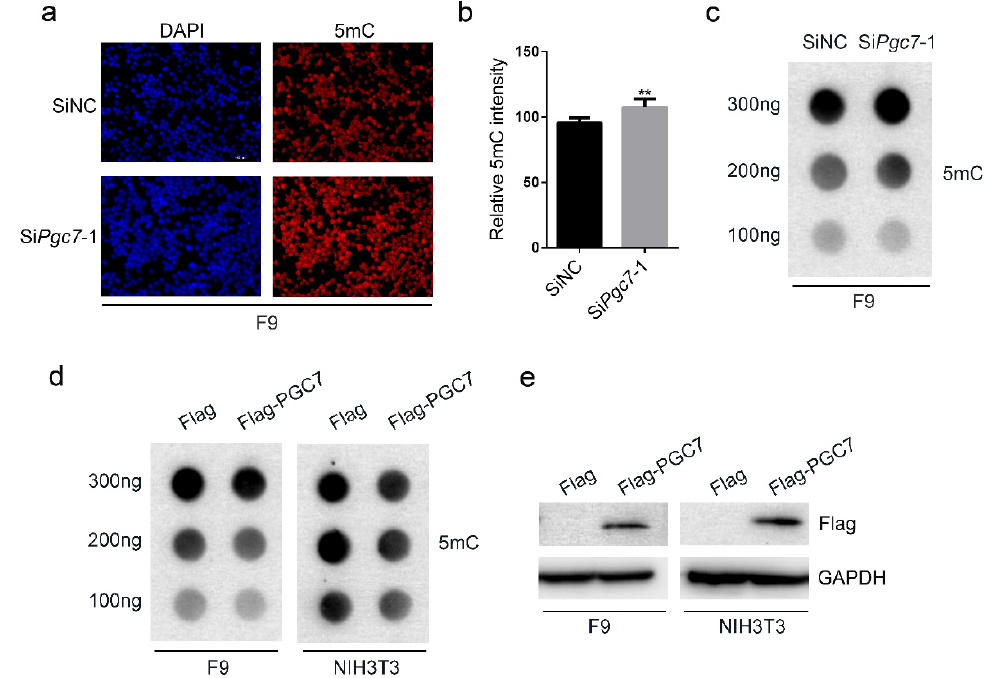
Figure 1. PGC7 regulates genome-wide DNA methylation. ( a , b ) Knockdown of Pgc7 in F9 cells increased genome-wide 5 mC levels. F9 cells were transfected with SiNC or Si Pgc7 -1 for 36h, after which a methylation staining experiment was performed. ImageJ 1.49 software was used to determine 5 mC fluorescence intensity from five or more images for both the SiNC and Si Pgc7 -1 groups. ** p < 0.01. ( c ) Knockdown of Pgc7 in F9 cells increased genome-wide 5 mC levels. SiNC or Si Pgc7 -1 was transfected into F9 cells for 36 h. Genomic material was then extracted, and dot blot experiments were performed. ( d , e ) Overexpression of PGC7 in F9 and NIH3T3 cells reduced genome-wide 5 mC levels. F9 and NIH3T3 cells were transfected with p3×Flag-CMV-10 or p3×Flag-CMV-10-PGC7 for 36–48 h, respectively. ( d ) Genomic material was then extracted, and dot blot experiments were then performed. ( e ) Western blot analysis of the efficiency of PGC7 overexpression.